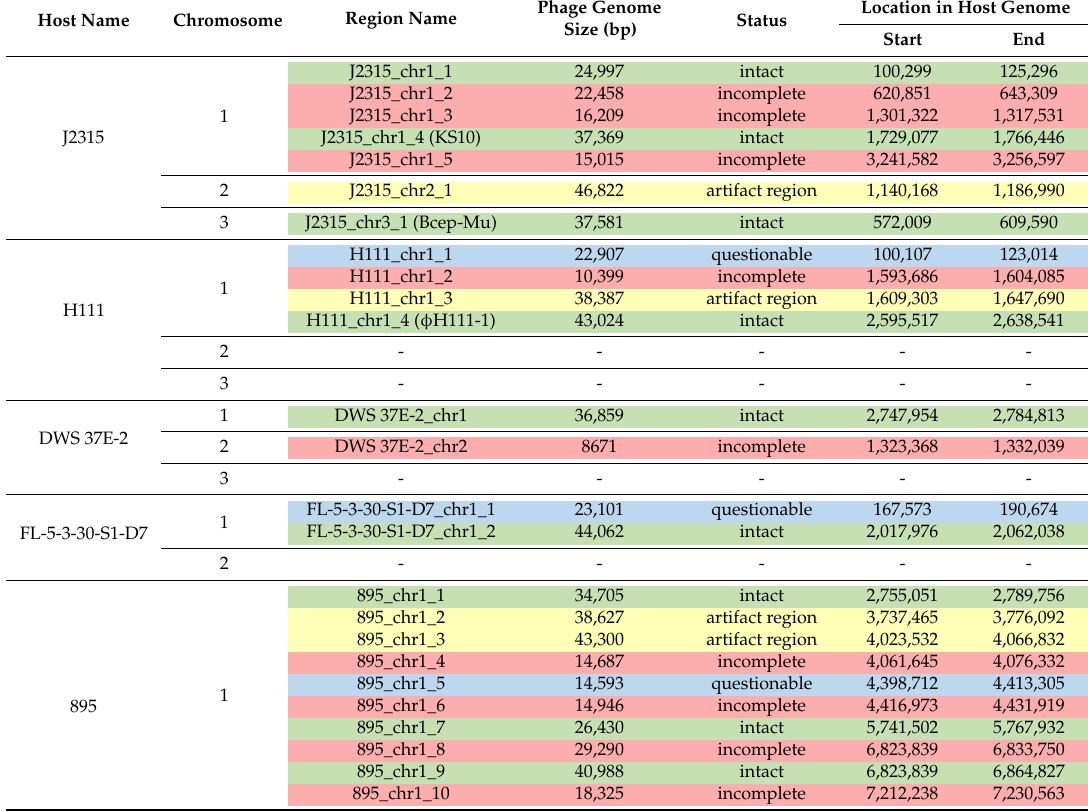
Table 2. Presence of prophages in Burkholderia cenocepacia genomes stored in the NCBI database. Regions types were marked with colors: intact (green), questionable (blue) incomplete (red) and artifact region (yellow). Table containing more detailed data can be found in Supplementary data (Table